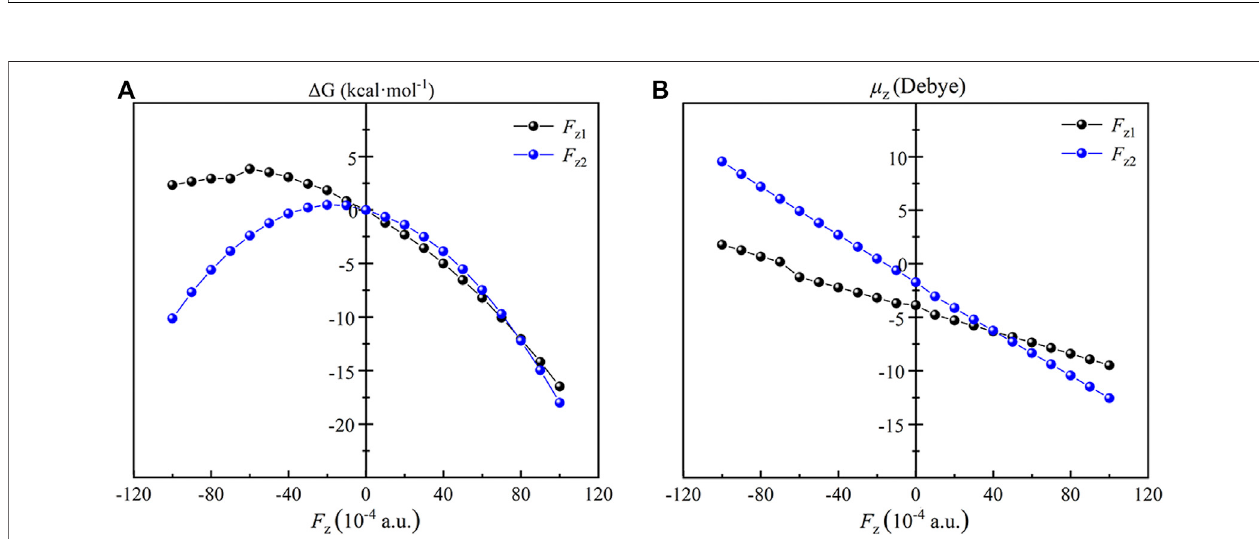
FIGURE 6 | Plots of the relative energies (A) and the dipole moments (B) of the RC as a function of the applied OEEFs.